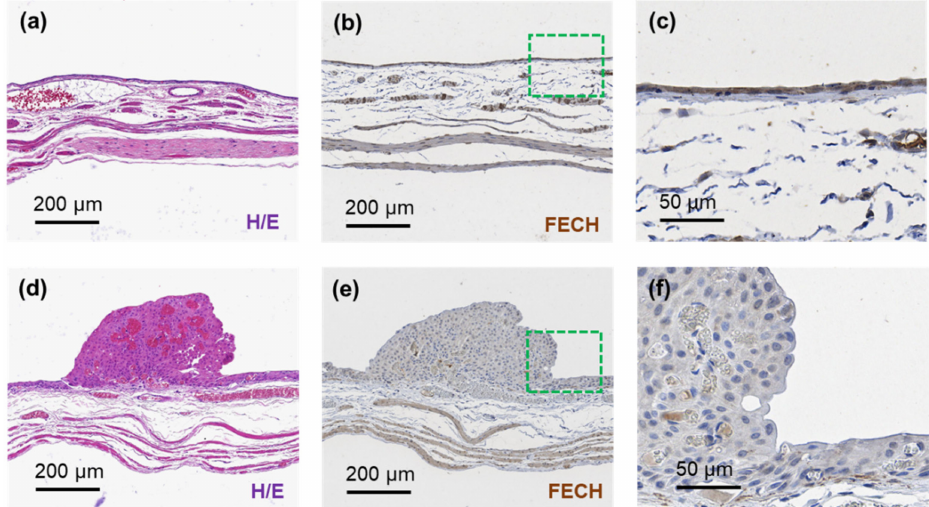
Figure 6. ( a ) H/E and ( b ) FECH staining of healthy bladder tissue, and ( c ) magnified image of the green dotted line in ( b ). ( d ) H/E and ( e ) FECH staining of a bladder cancer lesion, and ( f ) magnified image of the square dotted line in ( e